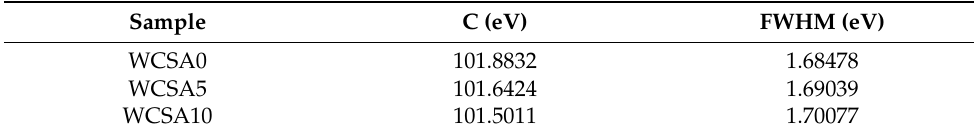
Table 6. Peak center (C) and FWHM from the curve fitting of